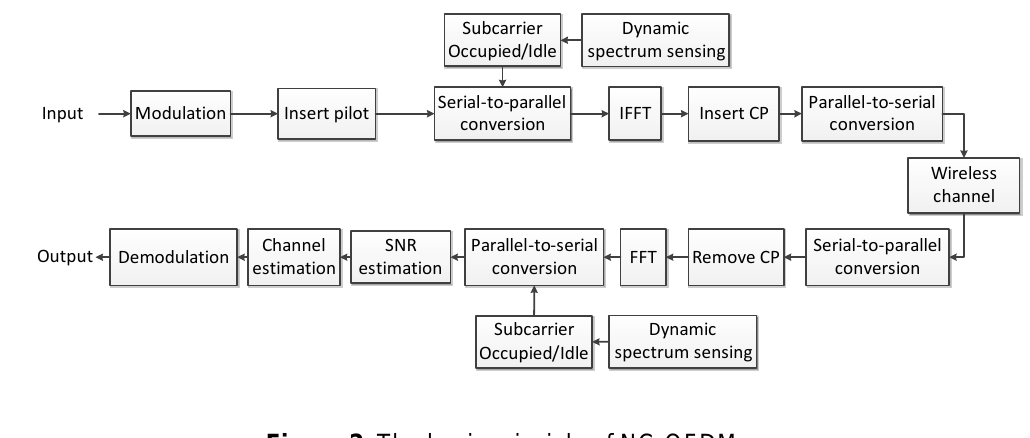
Figure 2. The basic principle of NC-OFDM